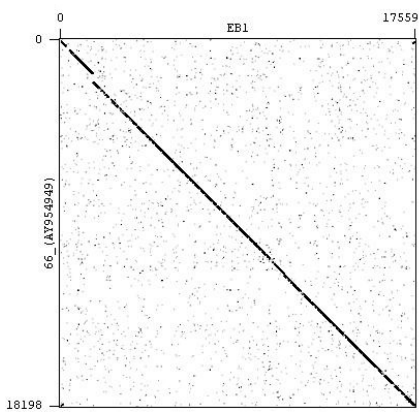
Figure 5. UPGMA tree constructed by the Geneious tree builder (software version 4.8) on the basis of a multiple genome alignment of 18 S. aureus phages belonging to the Podoviridae family. The position of the phage EB1 is marked by a dot.